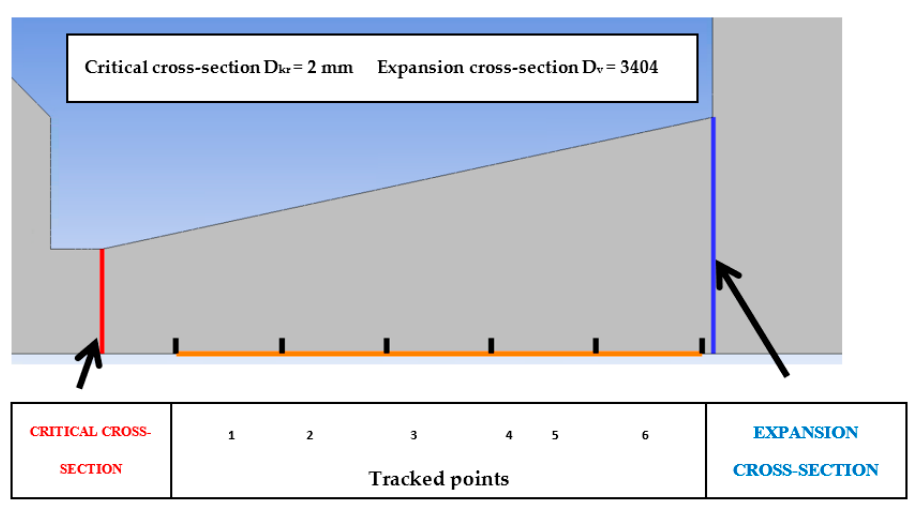
Figure 9. Measured points.